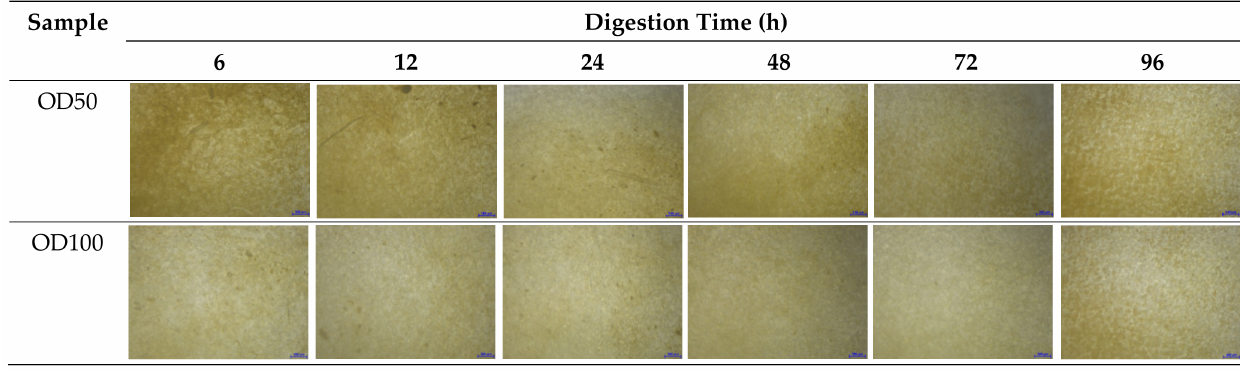
Figure 4. Microscopic observation of dried G. fisheri after oxidative digestion. Specimens were viewed on filter papers at 10 × objective.